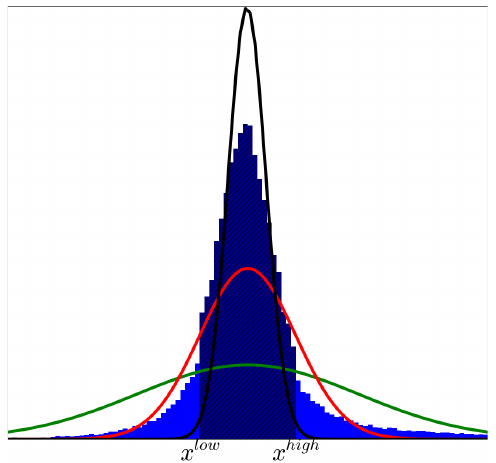
Figure 1. Distribution of one component of the Monte Carlo pos- terior ensemble. The histogram displays the raw posterior distribu- tion. The dark hatched part of the histogram depicts the proportion of the ensemble within the tolerance interval TI 68 , [ x low , x high ] (as defined in Sect. 2.2). The red curve represents the normal distribu- tion with the same mode and tolerance interval; the green one stands for a normal distribution with the same mode and the same standard deviation; the black one is the posterior distribution computed with the maximum likelihood couple of uncertainty matrices, presenting under-estimated skewness compared with the Monte Carlo distribu-